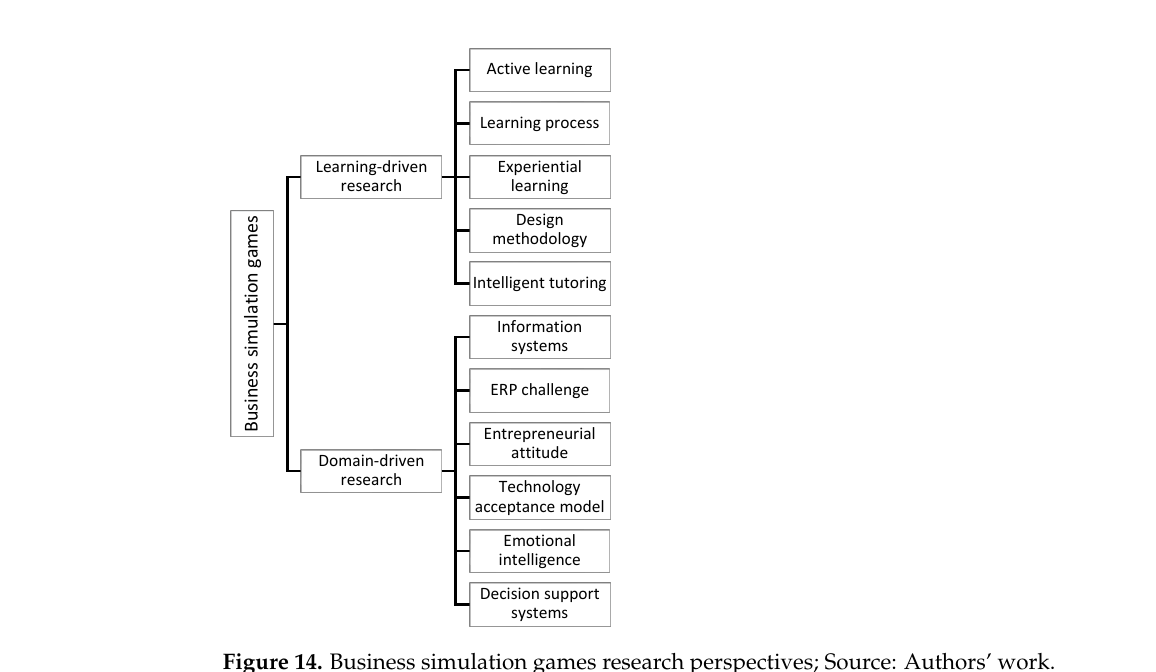
Figure 14. Business simulation games research perspectives; Source: Authors’ work.